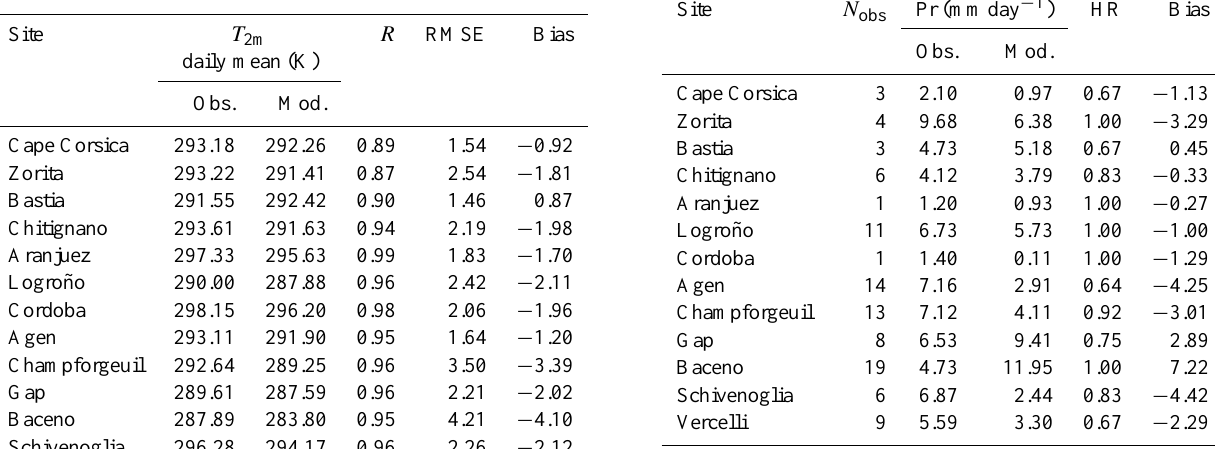
Table 4. Correlations ( R ), root mean squared error (RMSE) and bias of measured and modeled daily mean averaged values of 2m temperature (K). The bias expressed the (model) minus (observa- tions) values. Site T 2m R RMSE Bias daily mean (K) Obs.